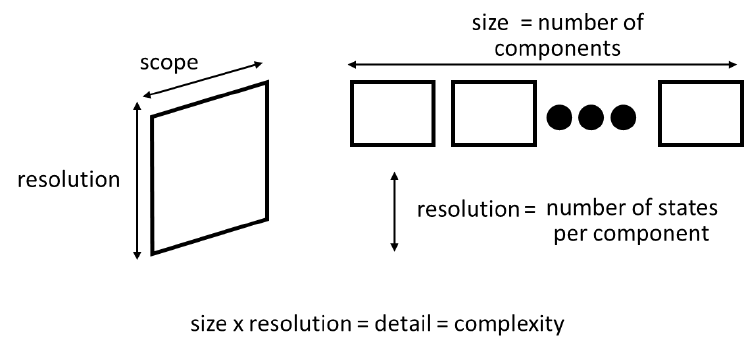
Figure 1. Zeigler, et al. define a simulation model’s complexity as driven by its level of detail, which is the product of the model’s size and scope, resolution, and interactions. Reprinted with permission from Ref. [1]. Copyright 2019 Elsevier